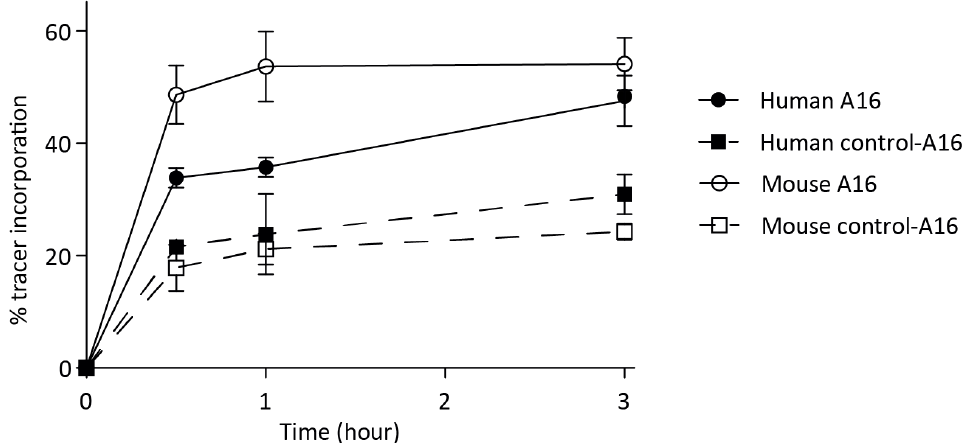
Figure 3. 111 In-labelled tracers (A16—solid line, control-A16—dotted line) were added to human ( (cid:4) , ) and mouse ( (cid:3) , ) thrombi. At indicated time points, thrombi were washed, and the amount of (cid:32) (cid:35) tracer uptake was measured in a gamma